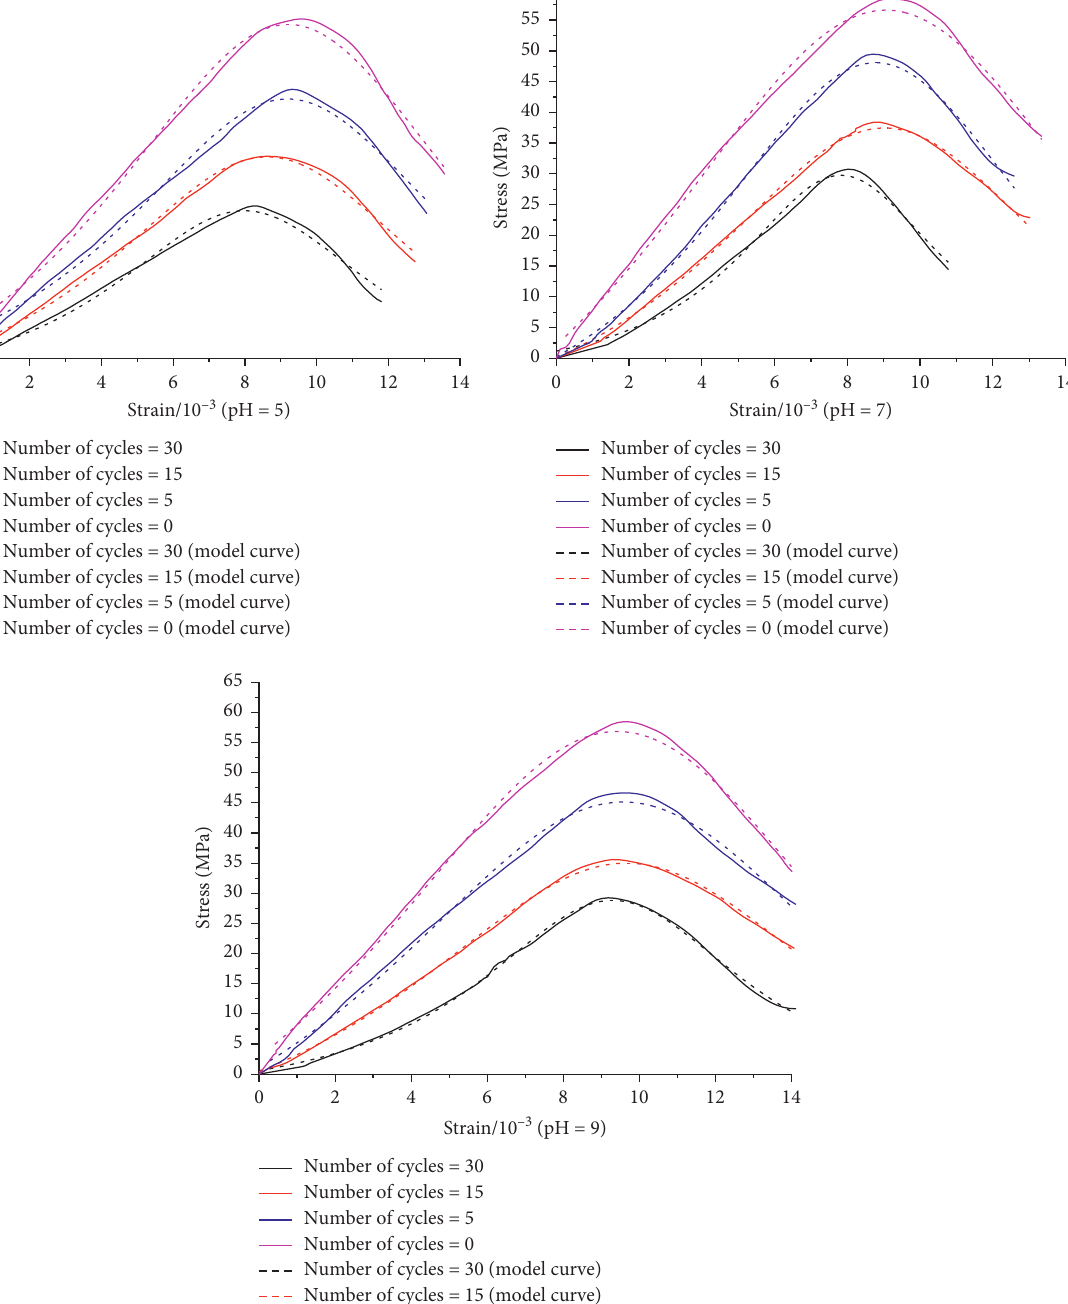
Figure 6: Comparison of test and model